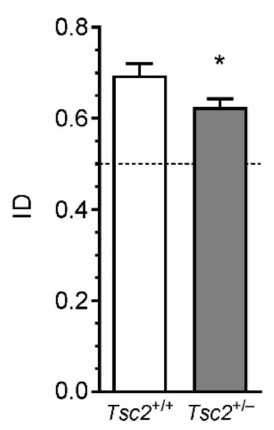
Figure 9. The effect of Tsc2 haploinsufficiency in mice on behaviour (cognitive function). The memory of male mice was analysed in a novel object recognition test. Index of discrimination (ID) was calculated, as described in the Methods section. Presented results are means ± SEMs from n = 10 animals in each group. * p < 0.05, compared to control, as determined using Student’s t -test. Each data point is from a separate